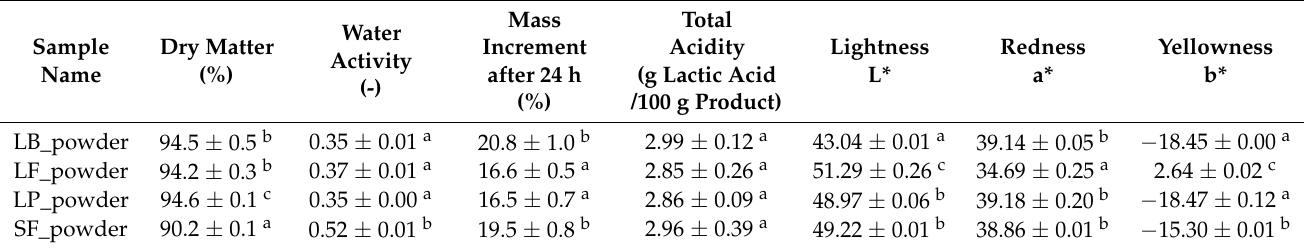
Table 2. Physicochemical properties of fermented beetroot